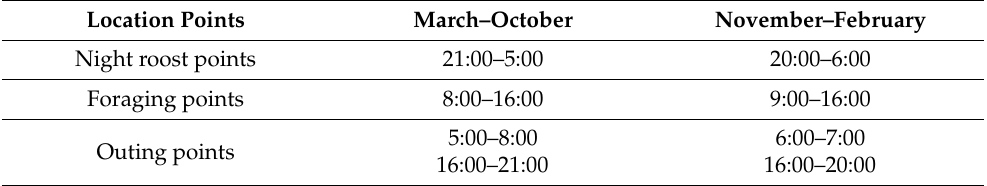
Table 3. Selection rules of study periods for location